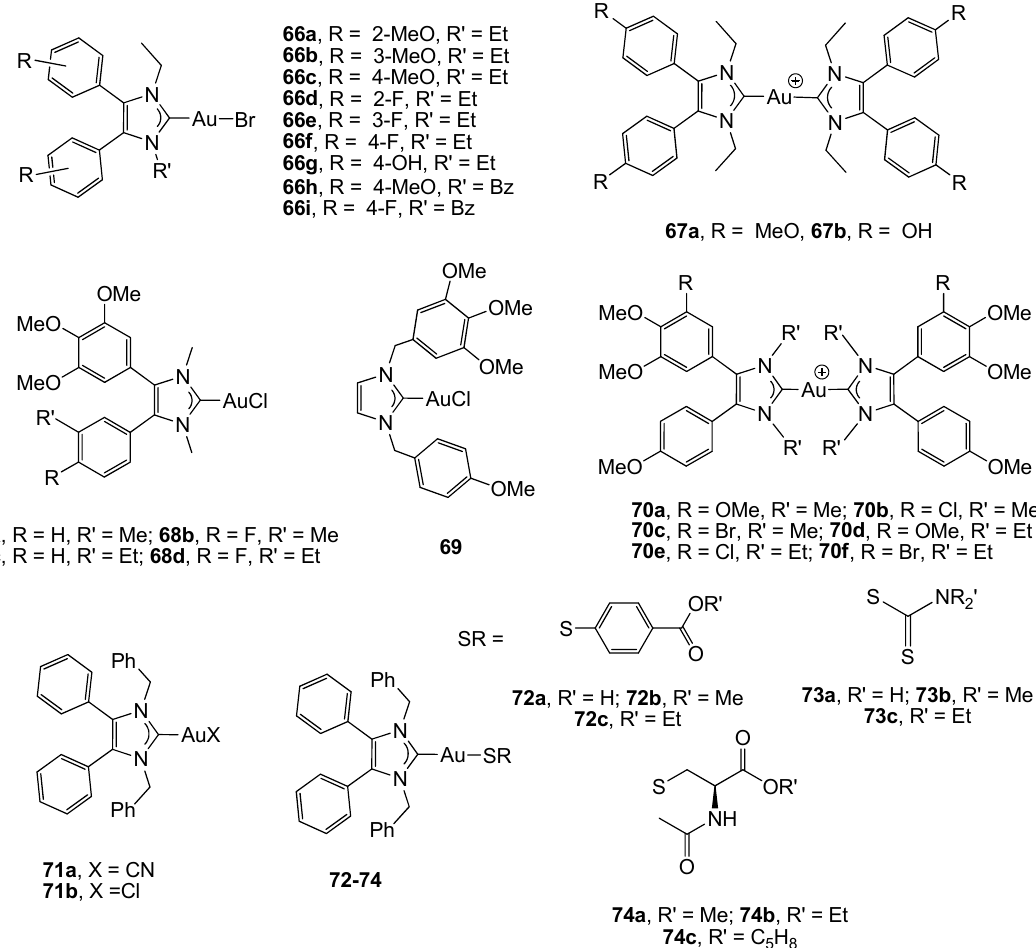
Figure 5. Carbene gold(I) derivatives based on the 4,5-diarylimidazol moiety.